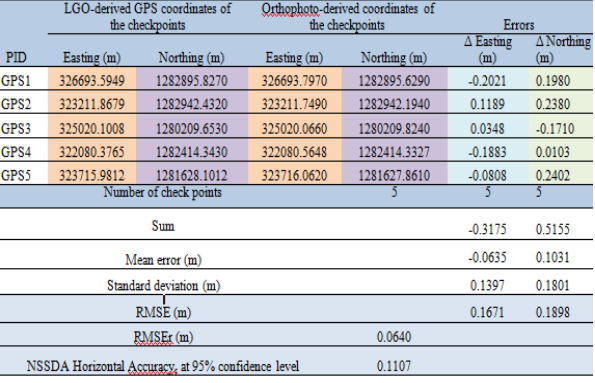
Table 4. Comparison between GPS coordinates from LGO and